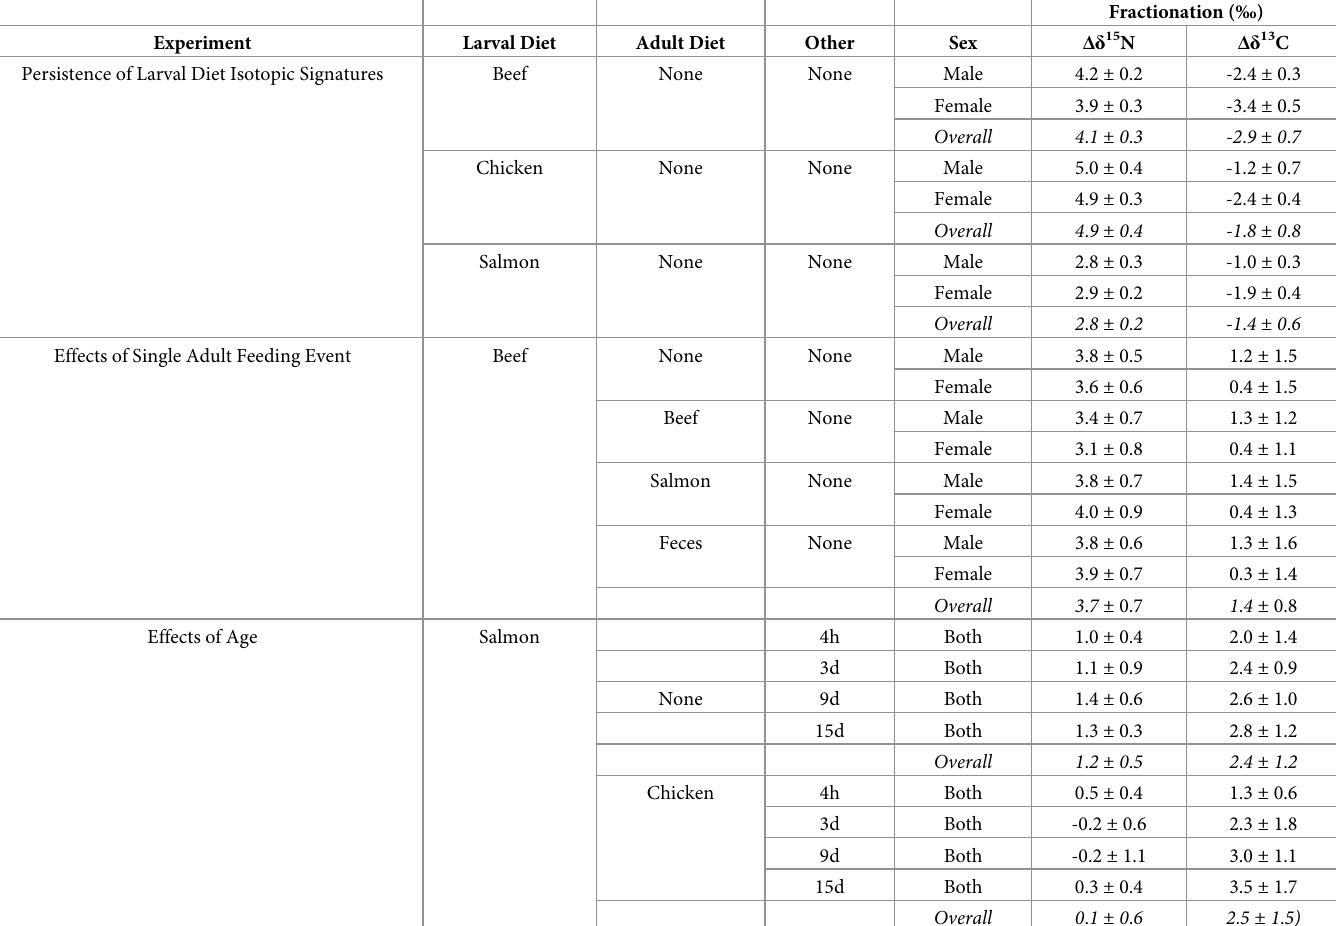
Table 2. Summary of isotopic data from feeding